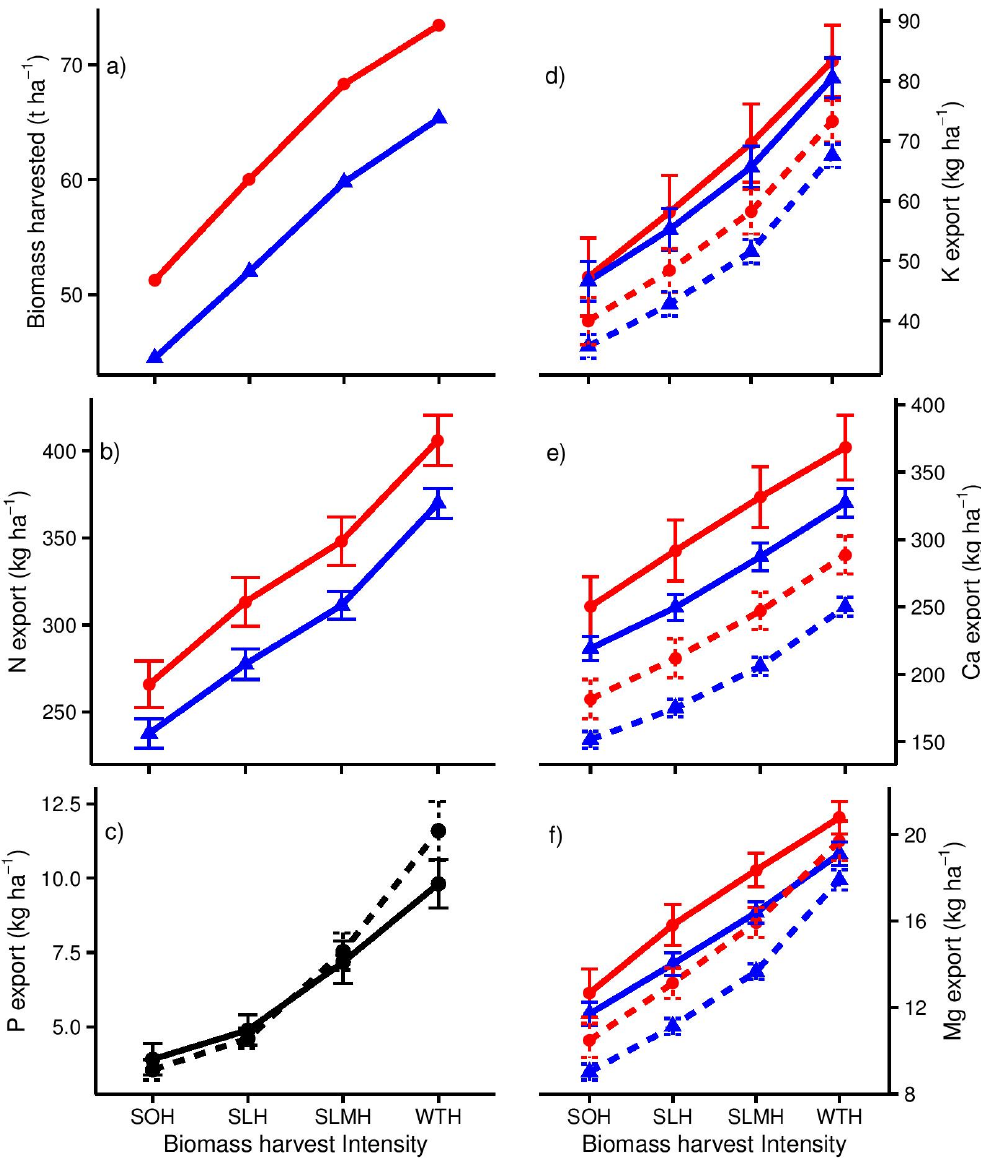
Figure 2. Average mass per unit area (kg · ha − 1 ) of exported biomass and nutrients as a function of biomass harvest intensity, stand composition, and tree marking procedure. Only variables explaining more than 1% in the variation of nutrient export are presented in this figure. Red lines correspond to diameter ‐ limit cutting, blue lines represent selective cutting, solid lines are for pure sugar maple stands, and dashed lines correspond to mixed sugar maple ‐ yellow birch stands. The black line for P correspond to the values averaged over both tree marking procedure. SOH = stem only harvesting, SLH = stem + large branch harvesting, SLMH = stem, large + medium branch harvesting, WTH = whole tree harvesting. Error bars correspond to standard deviations.